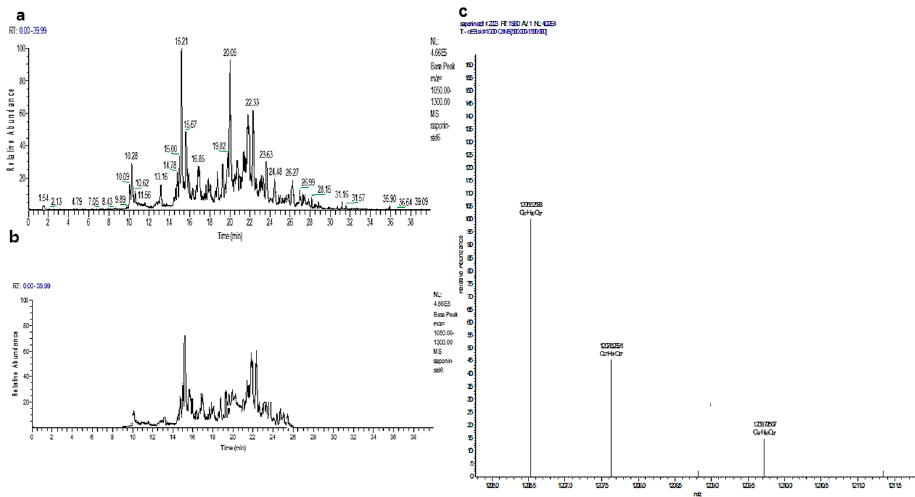
Figure 1. LC / TOF / MS analysis of Camellia sinensis seed extracted saponin mixture and the isolated pure saponins fraction (Base peak intensity chromatogram at m / z 1050–1300). ( a ) LC-MS